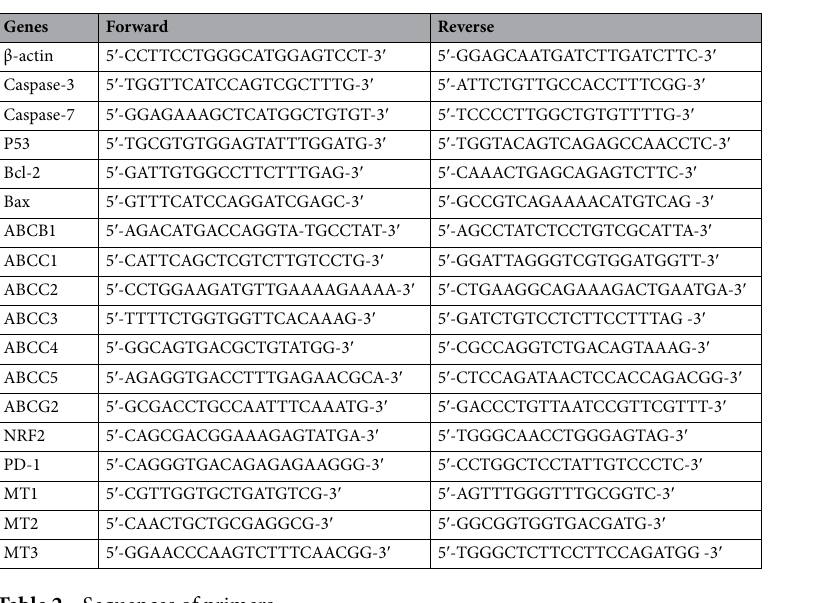
Table 2. Sequences of